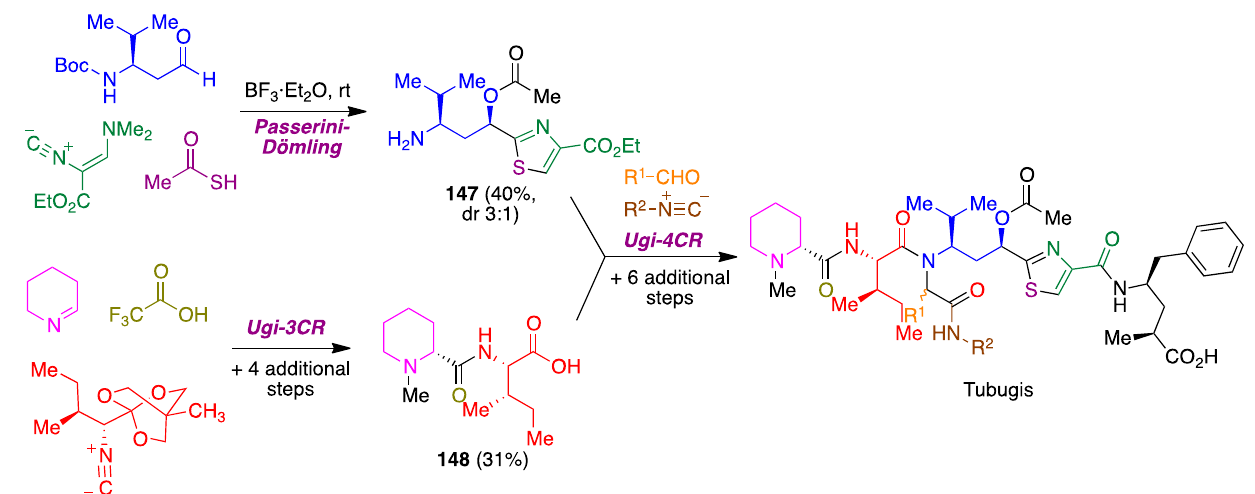
Scheme 69. Synthesis of tubugis by combination of three multicomponent